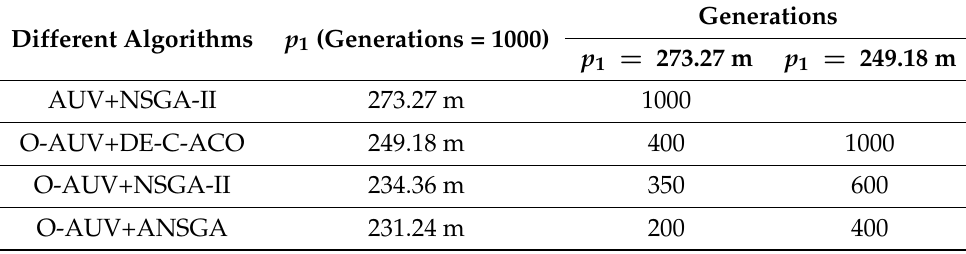
Table 5. Comparison between different algorithms and models.